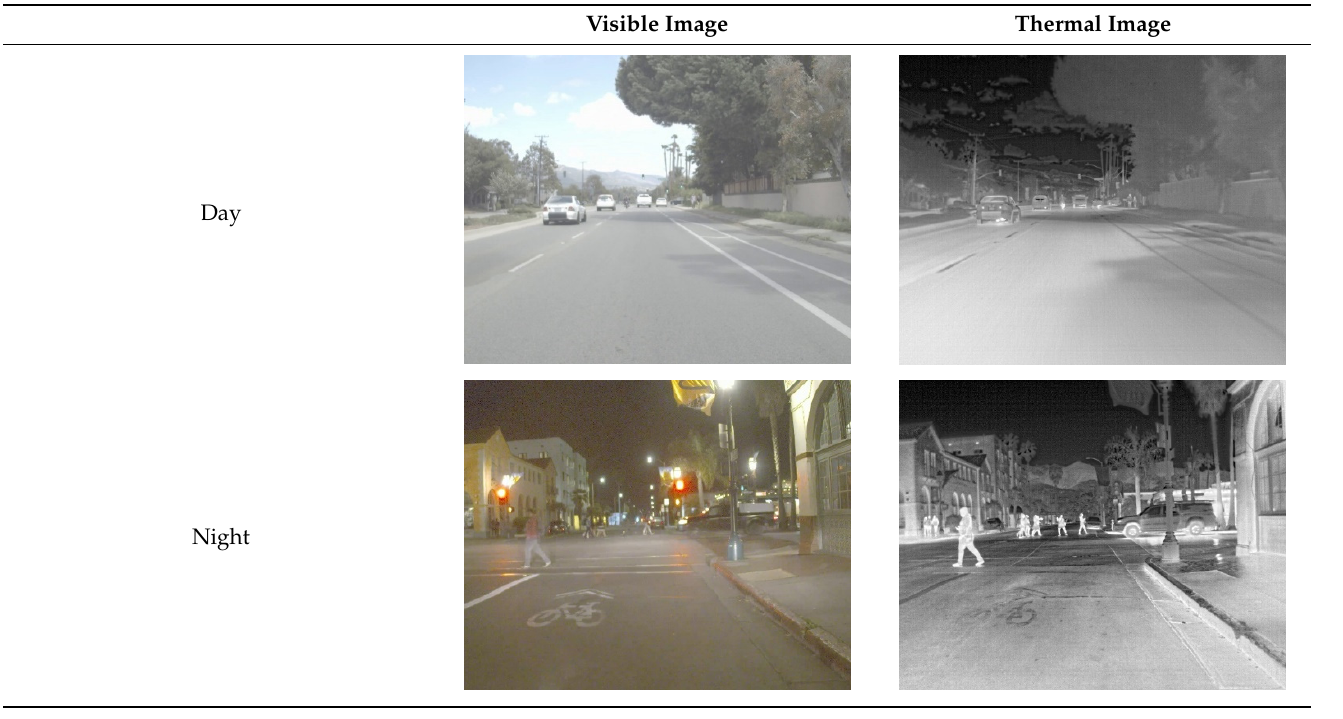
4 of 19 Figure 1. The flowchart of the research framework. 3.1. Illumination Conditions Discrimination To choose the most suitable fusion parameters, the illumination conditions (day or night) of the image must be determined in advance. In this study, the original FLIR dataset [14] was used for model training. The original FLIR dataset [14] captured vehicles and pedestrians on the streets and highways of Santa Barbara, California, during daytime (60%) and nighttime (40%) from November to May.